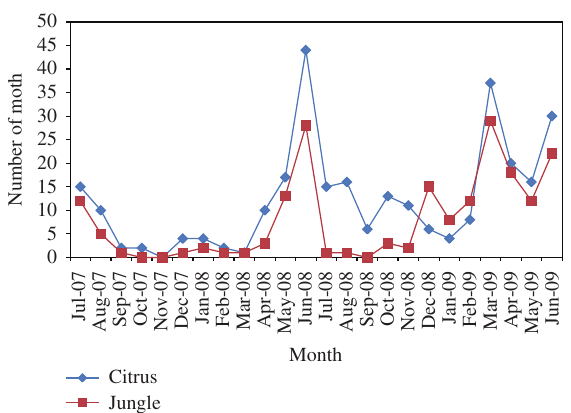
FIGURE 1: Flight activity of adult Eudocima moths during July 2007 to June 2009 in citrus orchard and secondary